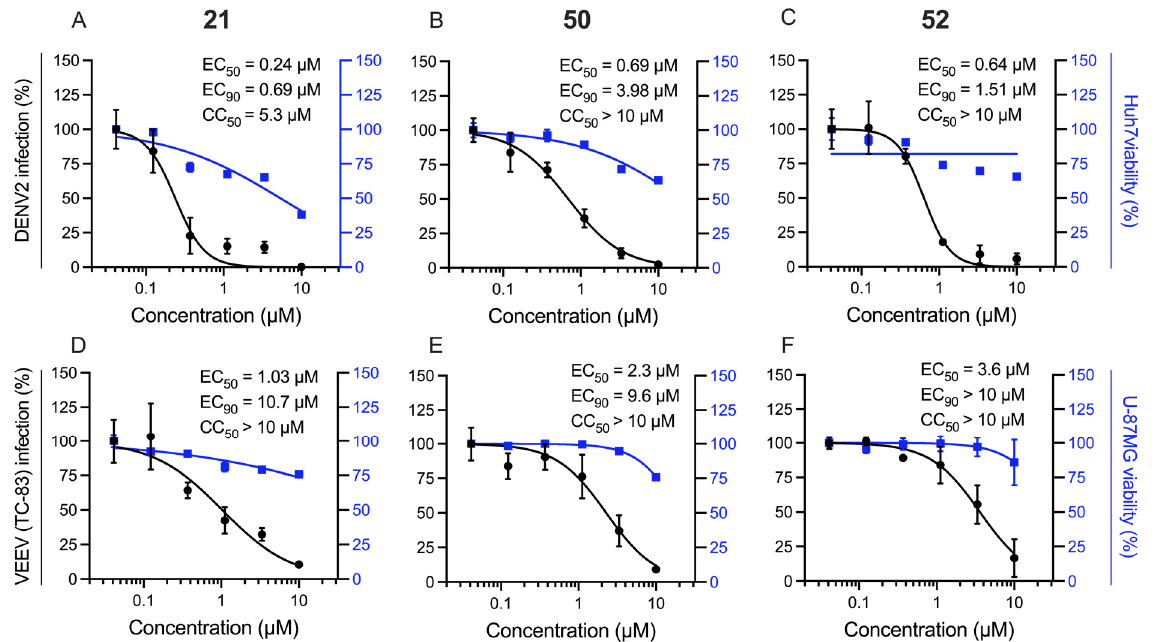
Figure 3. Compounds 21 , 50 and 52 suppress both DENV2 and VEEV (TC-83) infection. Dose response of DENV2 (black) and cell viability (blue) to compounds A: 21 , B: 50 , C: 52 and dose response of VEEV (TC-83) (black) and cell viability (blue) to compounds D: 21 , E: 50 , F: 52 ; each measured by luciferase and AlamarBlue assays, 48 hours post-infection ( A – C ) or 18 hours post-infection ( D – F ). Data are plotted relative to DMSO control. Shown are representative experiments from at least two conducted, each with 4 biological replicates; shown are means ± SD.